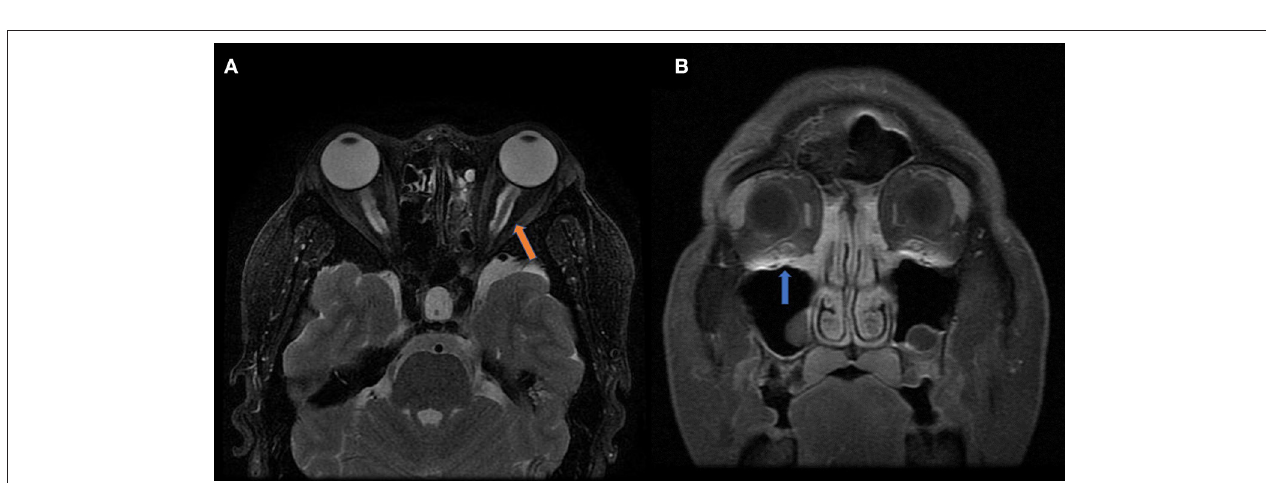
FIGURE 2 | MRI findings of OPN patients with Graves’ disease. (A) Coronal contrast enhanced T1-weighted MRI showing extraocular muscle belly enlargement (arrow). (B) Coronal contrast enhanced T1-weighted MRI showing thickening and enhancement of the left optic nerve sheath (arrow).